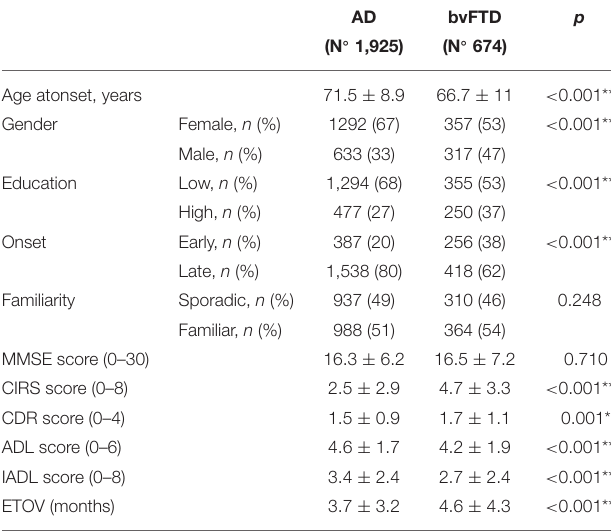
TABLE 1 | Baseline characteristics of the AD and bvFTD